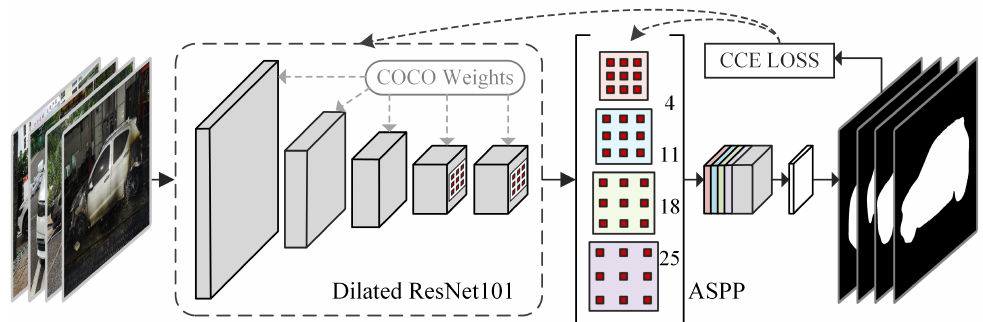
Figure 3. Structure of the foreground extraction